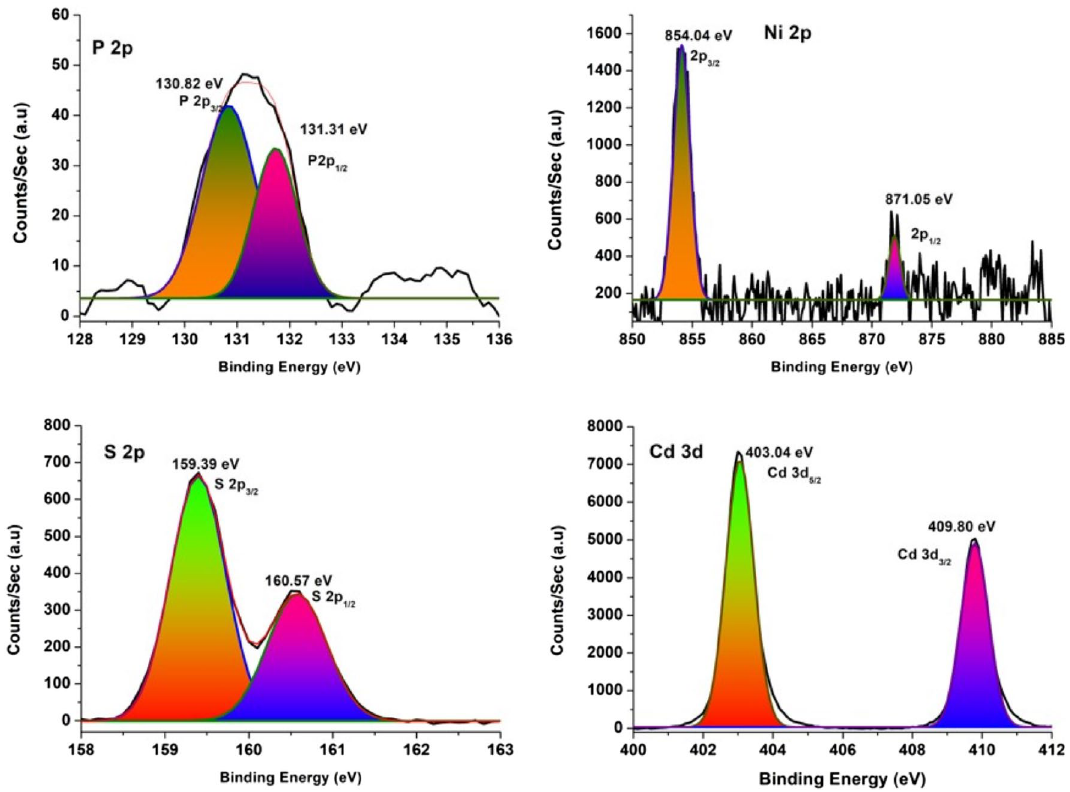
Figure 5. XPS spectra of Ni 2 P/CdS nanostructures, in images ( a ) Ni 2p, ( b ) S 2p, ( c ) P 2p and ( d ) Cd